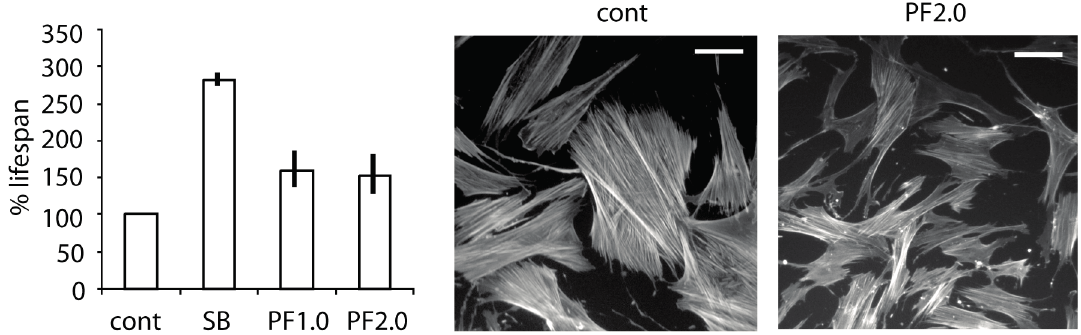
Figure 4. Increased replicative lifespan (±SD; n = 3) and improvement cellular morphology in WS cells using PF-3644022. Cont = control, SB = SB203580 at 2.5 µM, PF1.0 and PF2.0 = PF-3644022 at 1.0 and 2.0 µM respectively. White bar = 100 µm (for methods